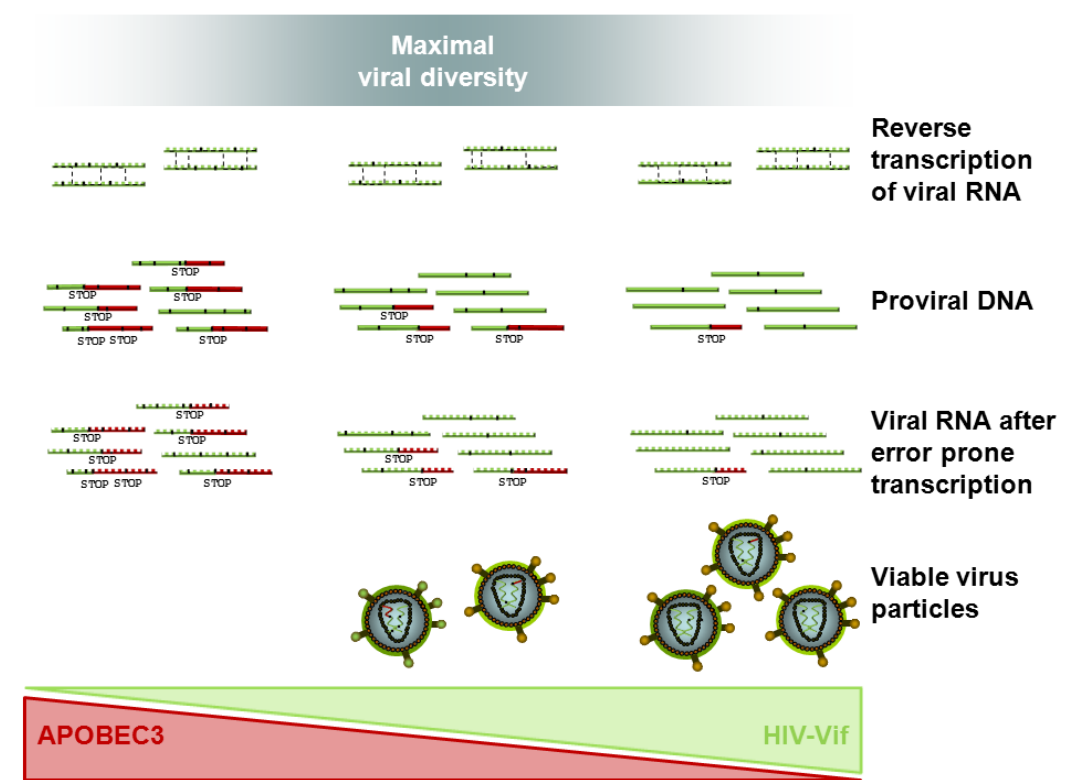
Figure 3. The APOBEC3-HIV-1 Vif balance determines the viral mutation rate in particular with respect to G-to-A hypermutations. The higher the mutation rate (right to left) the more mutations (black marks) are introduced into the viral genome during the viral replication cycle, including nonsense mutations (STOP codons, represented by a following red genome sequence) and missense mutations leading to a change in the coded amino acid. Recombination by template switching during reverse transcription (sketched by a black dashed line) is likely to alleviate the deleterious effect of mutations and to allow for higher viral variability. Increasing the mutation rate decreases the number of viable virus particles but drives the viral population through a regime of maximal diversity before extinction occurs through lethal mutagenesis (right to